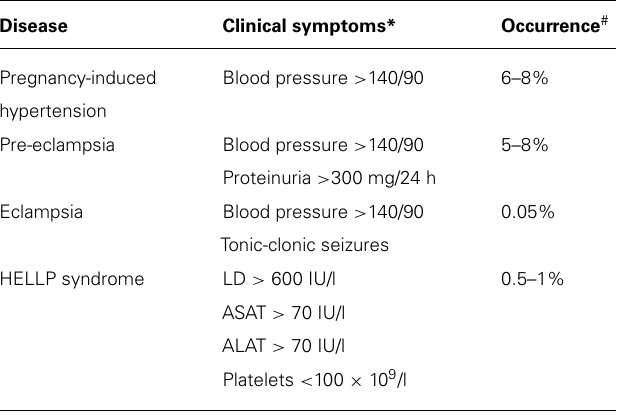
Table 1 | Clinical subtypes of pregnancy-induced